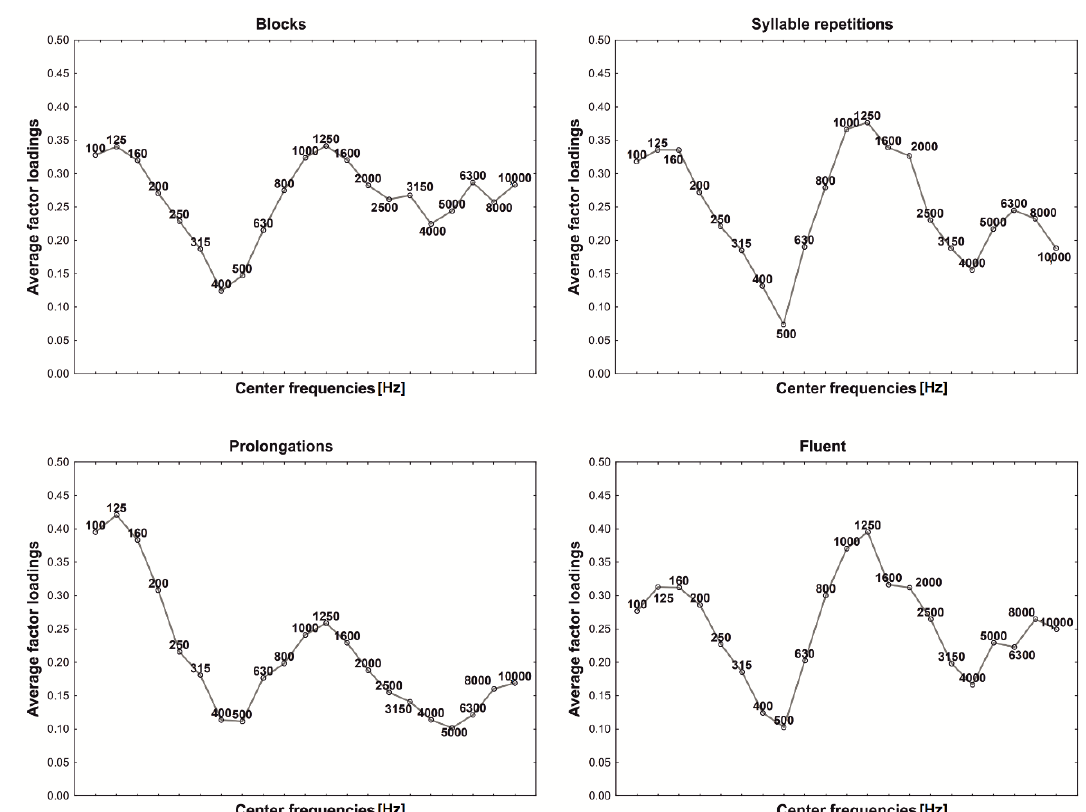
Figure 5. Prolongation spectrogram with G 1 (red) and G 2 (black) components. As can be observed, the shape of both G1 and G2 reflects the general time-frequency structure of the analysed utterance, but it is G2 which reflects higher frequencies while G1 concentrates on the lower ones instead.